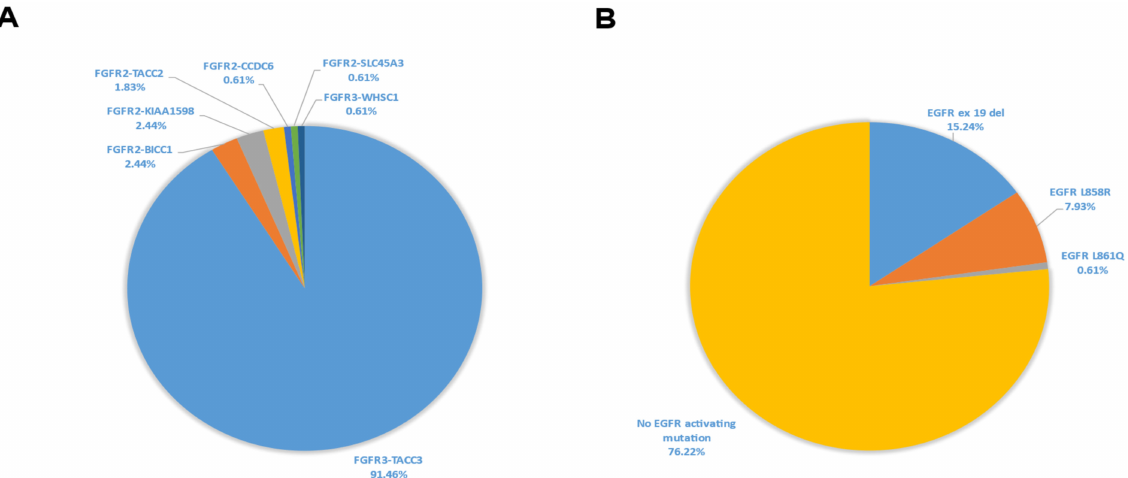
Figure 2. FGFR2/3 fusion subtypes distribution ( A ) and prevalence of co-existing EGFR sensitizing mutations ( B ) in aNSCLC in the GH electronic database. Abbreviations: aNSCLC—advanced non- small cell lung cancer; EGFR —epidermal growth factor receptor; FGFR —fibroblast growth factor receptor; GH—Guardant